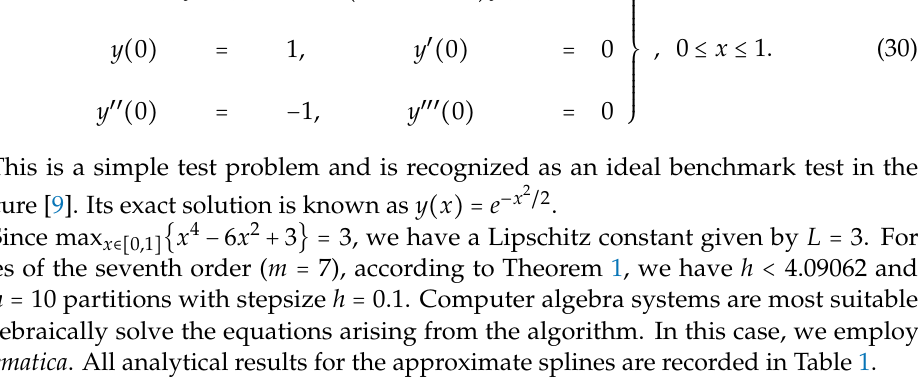
Table 1. Spline approximations for the scalar problem given in Equation (30).